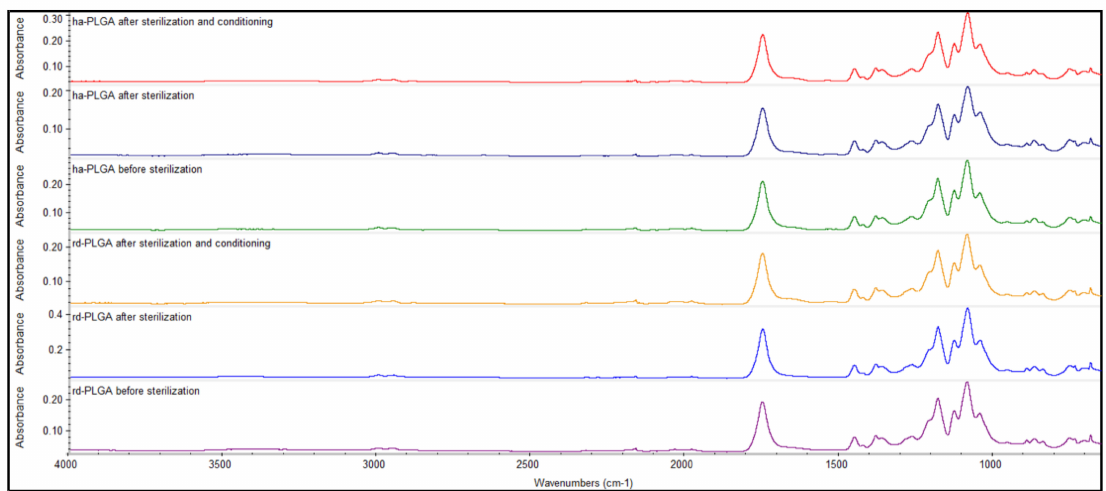
Figure 2. Representative FTIR spectra of rd- and ha-PLGA fleeces before and after sterilization, and after sterilization and conditioning. The spectra show that the sterilization and conditioning procedures did not alter the chemical composition of neat PLGA fleeces for both random and highly aligned fibers. Notable functional group assignments are as follows: band at 1748 cm − 1 corresponds to ester carbonyl stretch (C = O), band at 1085 cm − 1 corresponds to ether group stretching (C–O–C) and bands at 1452 and 1044 cm − 1 correspond to methyl stretching (C–H) and (C–CH 3 ) groups,